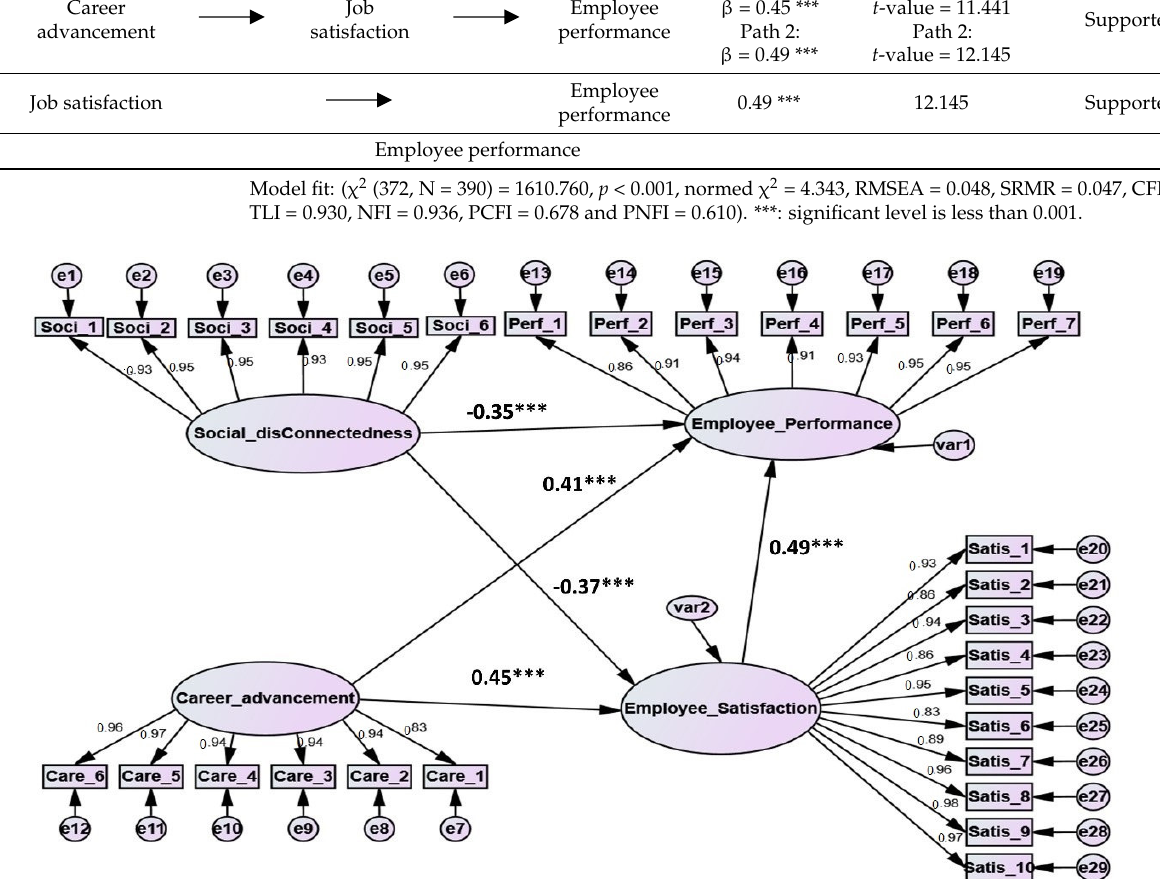
Table 4. The structural model results.